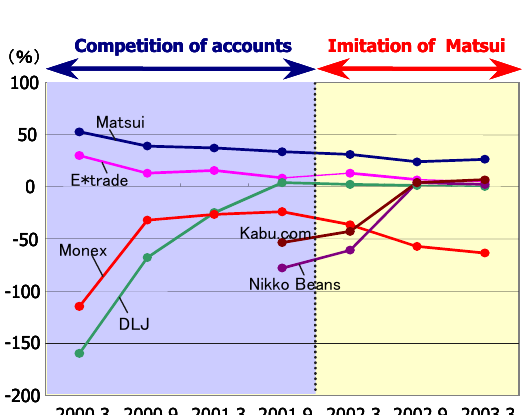
Figure 7. Ordinary Profit Ratio Figure 8. The Growth of